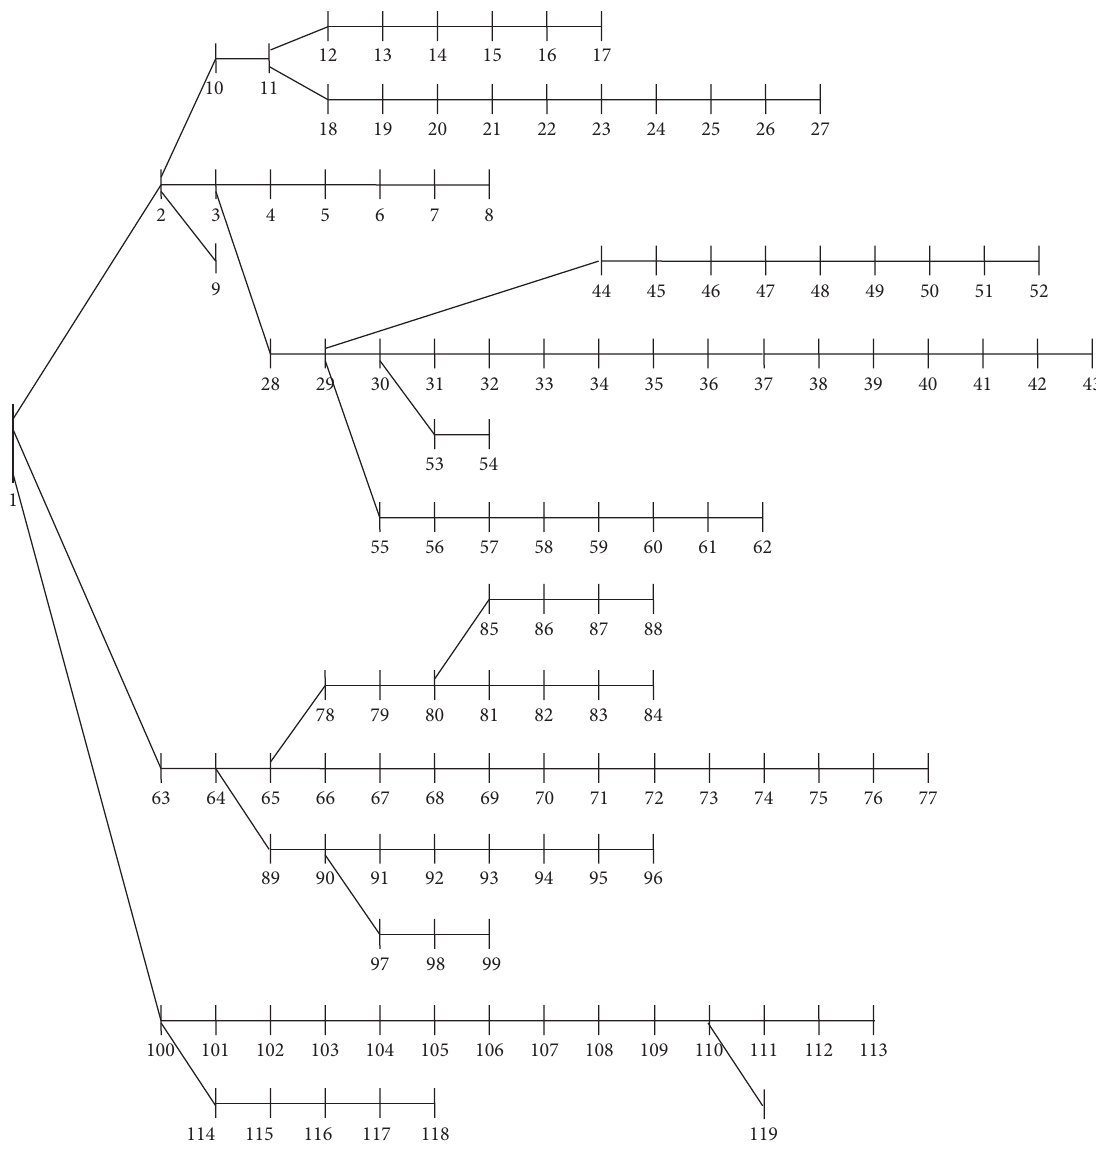
Figure 3: 119-Bus MG [64].